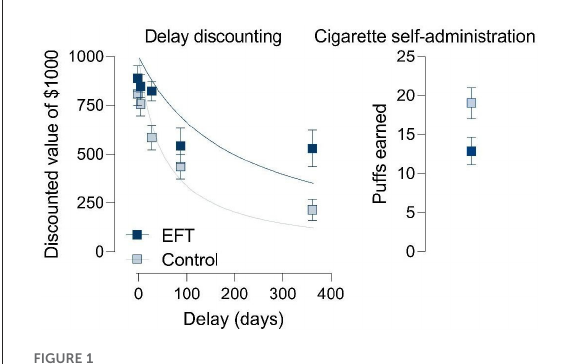
FIGURE1 Example data, replotted from Stein et al. (10), showing effects of an episodic future thinking (EFT) intervention on delay discounting (left) and the number of cigarette puffs earned during a self-administration task (right) in cigarette